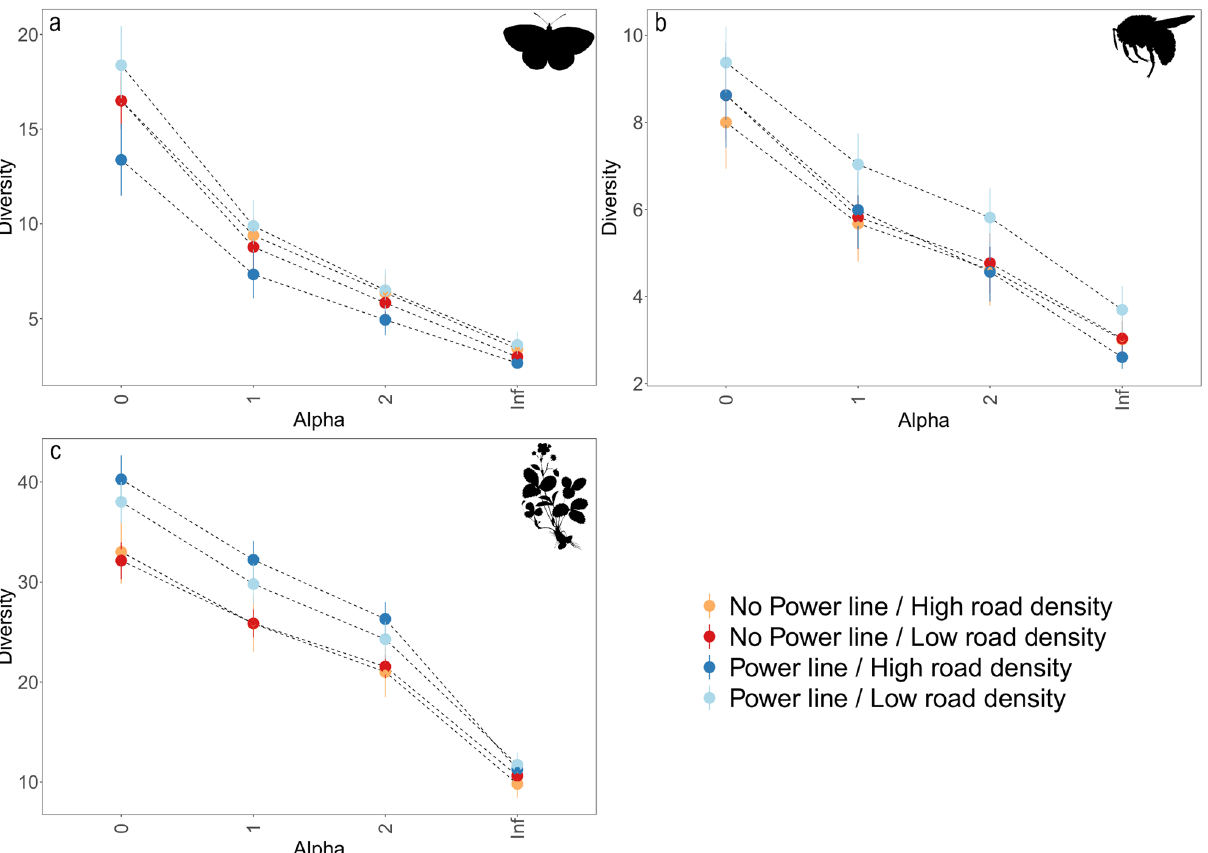
Figure 3. Diversity profiles for butterflies ( a ), bumblebees ( b ), and plants ( c ). Each value of alpha represents a different biodiversity index: 0 = species richness, 1 = Shannon diversity, 2 = Simpson diversity and Inf = Berger- Parker. The indexes put different weights to rare and common species (i.e. rare species have the same weight as common species in alpha = 0 while Berger-Parker ignores rare species). Diversity is represented in Hill numbers, meaning that all indexes predict number of species and can thus be compared to each other. The bars represent the standard error of the mean. Note that the connections between points do not represent a relationship between indexes. Silhouette images were available under Public Domain license at PhyloPic (http:// phylo pic.